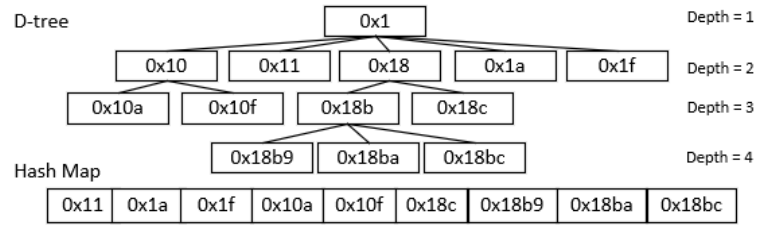
Figure 2. Example of four-dimensional decomposition tree